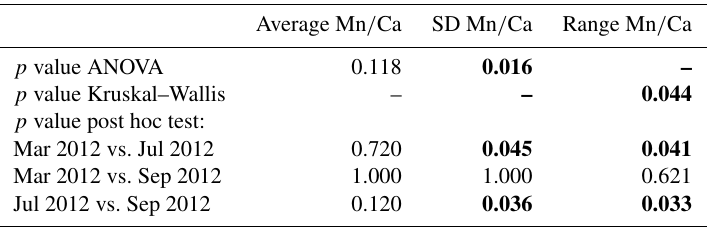
Table 3. Statistical results for comparison of Mn / Ca measurements of A. tepida for different sampling months. Significant results ( p value < 0 . 05) are indicated in bold.